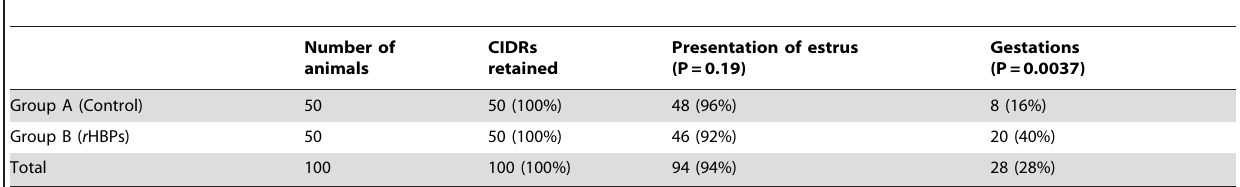
Table 3. Percentages of controlled internal drug release (CIDR) devices retained, presentation of estrus and gestations summarized for the different groups.